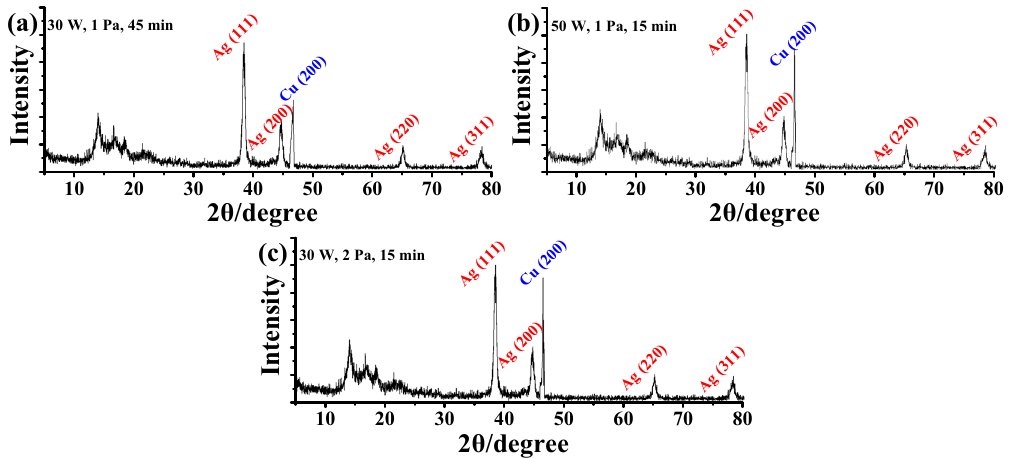
Figure 4: XRD patterns of PP samples with varying treatment conditions: ( a ) 30 W, 1 Pa, 45 min; ( b ) 50 W, 1 Pa, 15 min; and ( c ) 30 W, 2 Pa, 15